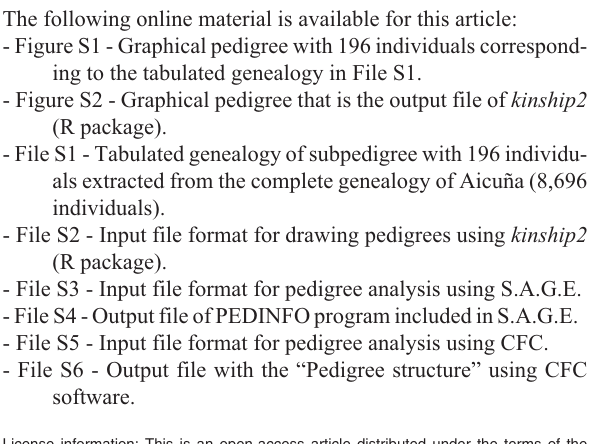
- Figure S1 - Graphical pedigree with 196 individuals correspond- ing to the tabulated genealogy in File S1. - Figure S2 - Graphical pedigree that is the output file of kinship2 (R